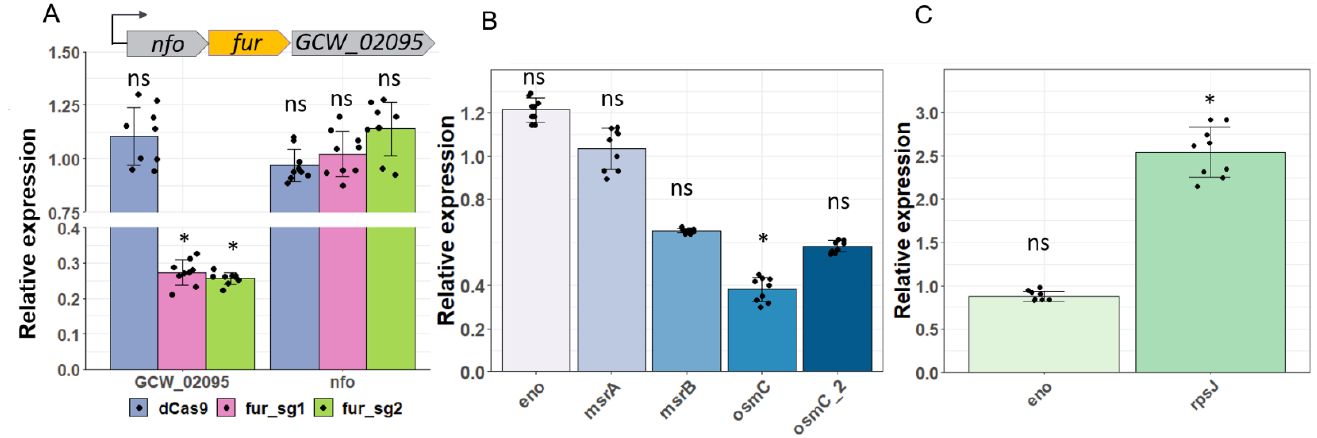
Figure 5. The effect of gene repression ( A ) Quantitative RT-PCR analysis showing levels of each gene of fur -containing operon in dcas9 and fur -sgRNAs-expressing transformants compared to those in wild-type bacteria. Top panel is a scheme of operon structure. ( B ) Expression changes of SpxA- regulated genes in transformants expressing dcas9 and the spxA-sgRNA1 (spxA-sg1) compared to dcas9 -expressing transformants. As a control, expression change of eno is shown. ( C ) Expression level of rpsJ –target of transcription factor WhiA–in the simultaneous dcas9 and whiA-sgRNA2 (whiA-sg2) expressing mycoplasma compared to dcas9 -expressing transformants. (*: p -value < 0.05; ns: not significant).